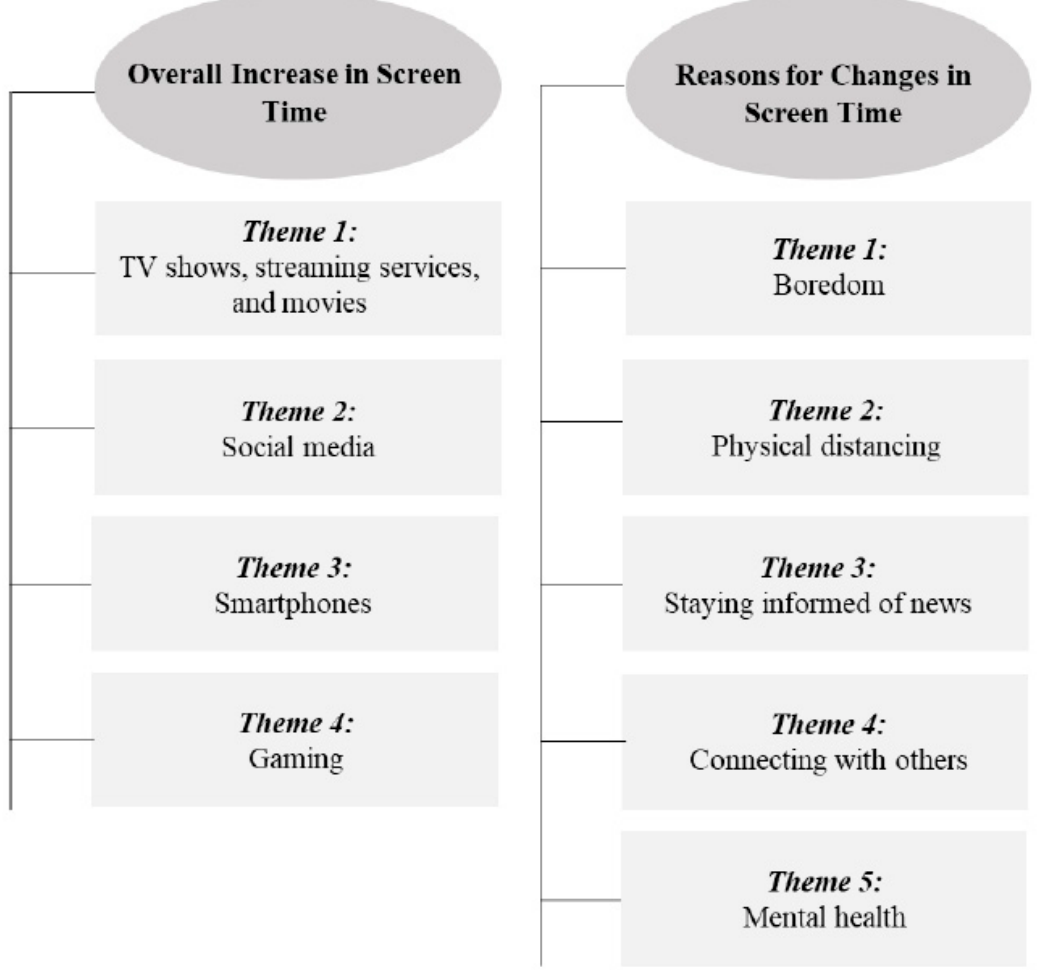
Figure 1. Main themes emerging from qualitative data on change in screen time behaviors.